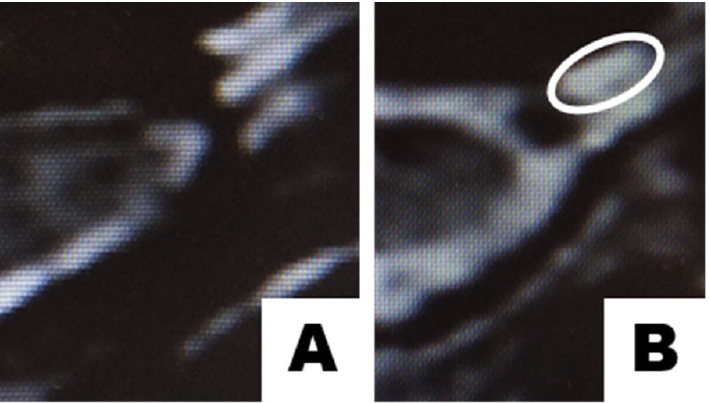
Figure 4. ( A )—Cervical spine MRI axial image of C2/3 intervertebral disc before and ( B )—5 months after the treatment according to [24,25]. The area of the prevalance of the regeneration over biodegradation is surrounded by the white line.